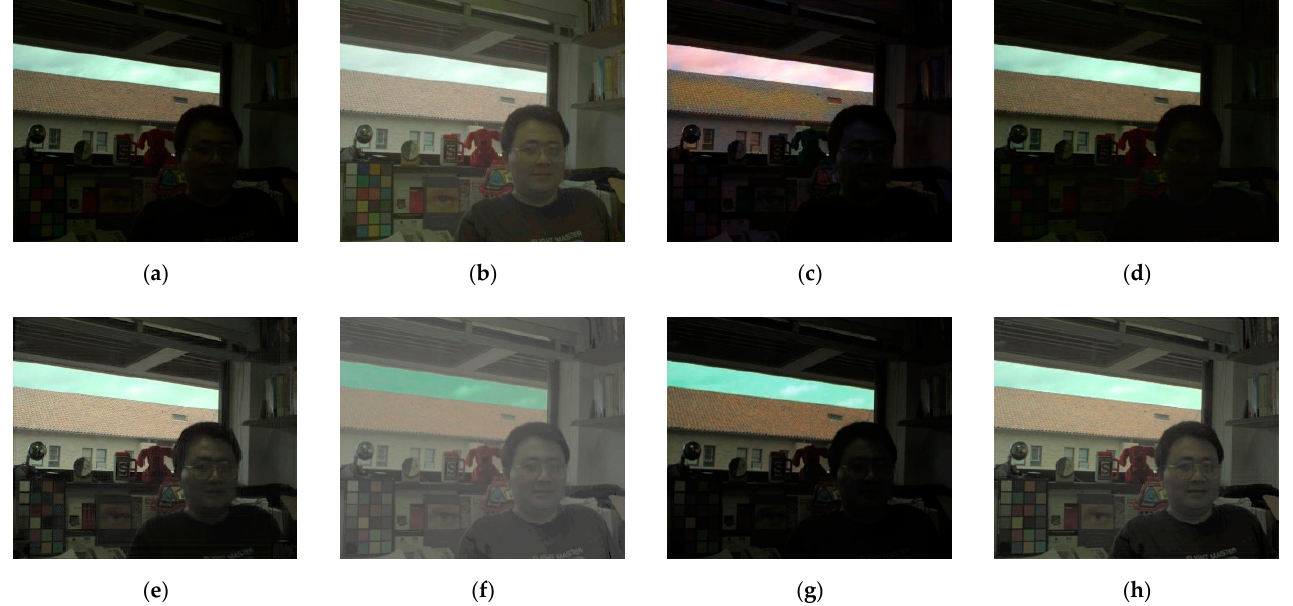
Figure 12. High-contrast image #2: ( a ) input, ( b ) target, ( c ) CycleGAN, ( d ) Lum CycleGAN, ( e ) EV GAN, ( f ) HDRCNN, ( g ) ExpandNet, and ( h ) the proposed model.